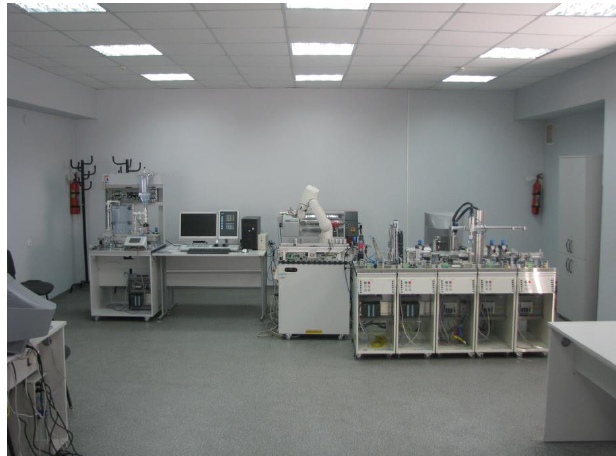
Figure 8. Laboratory of industrial mechatronic